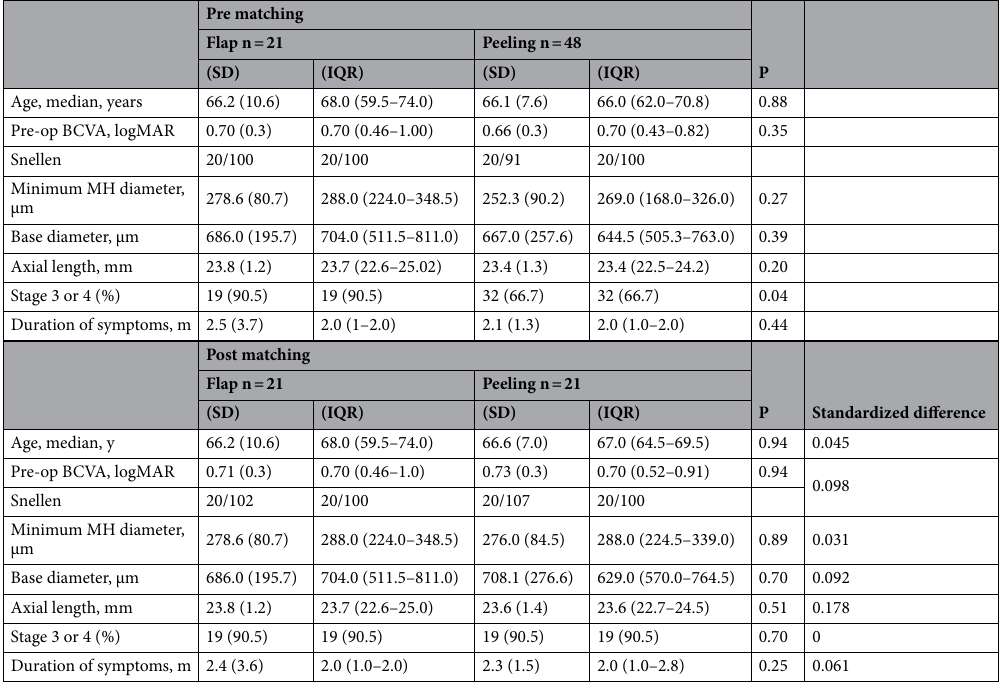
Table 1. Preoperative baseline characteristics before and after propensity score matching of the flap group and the peeling group. Wilcoxon’s rank-sum test, Fisher’s exact test. BCVA best-corrected visual acuity, MH macular hole, logMAR logarithm of minimum angle of resolution, pre-op pre-operative, SD standard deviation, IQR interquartile range (25th to 75th percentiles).